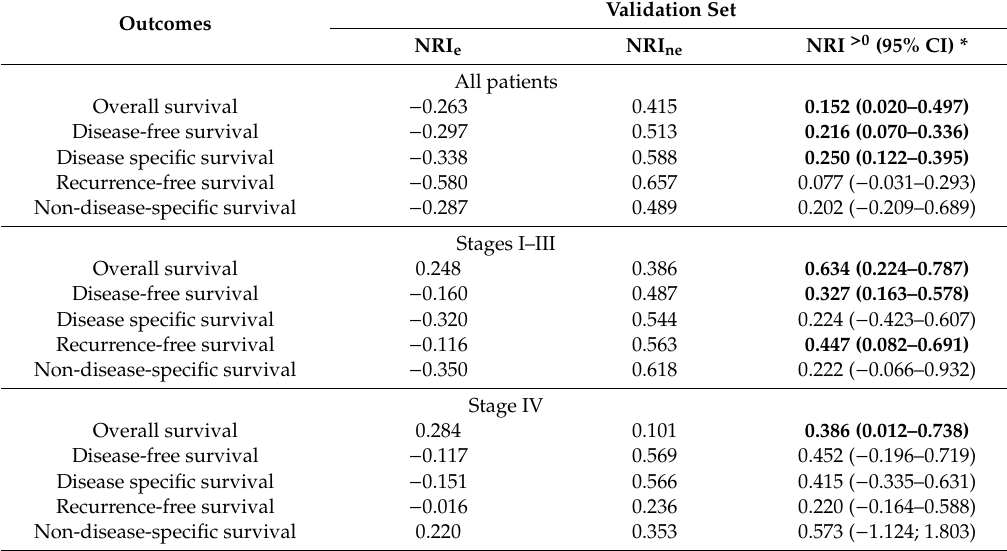
Table 4. Net reclassification improvement of adding comorbidity and functional status to the nomogram, overall and stratified by tumor